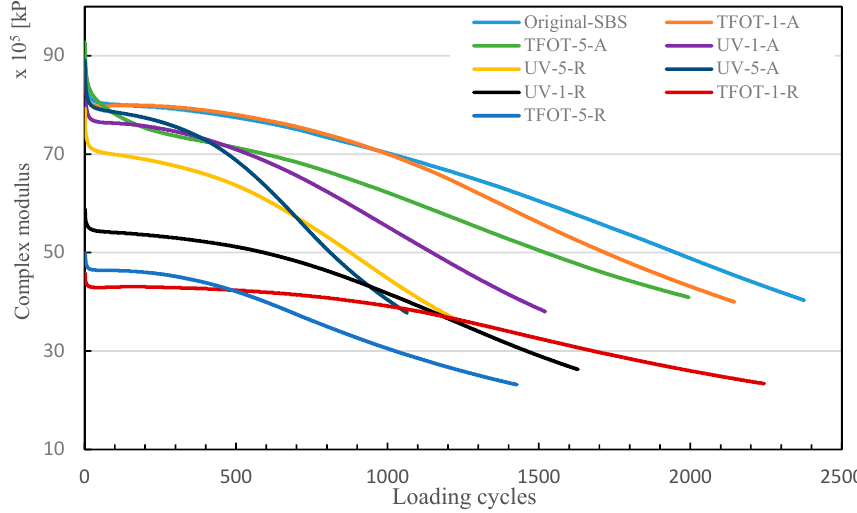
Figure 13. Fatigue life of different samples.